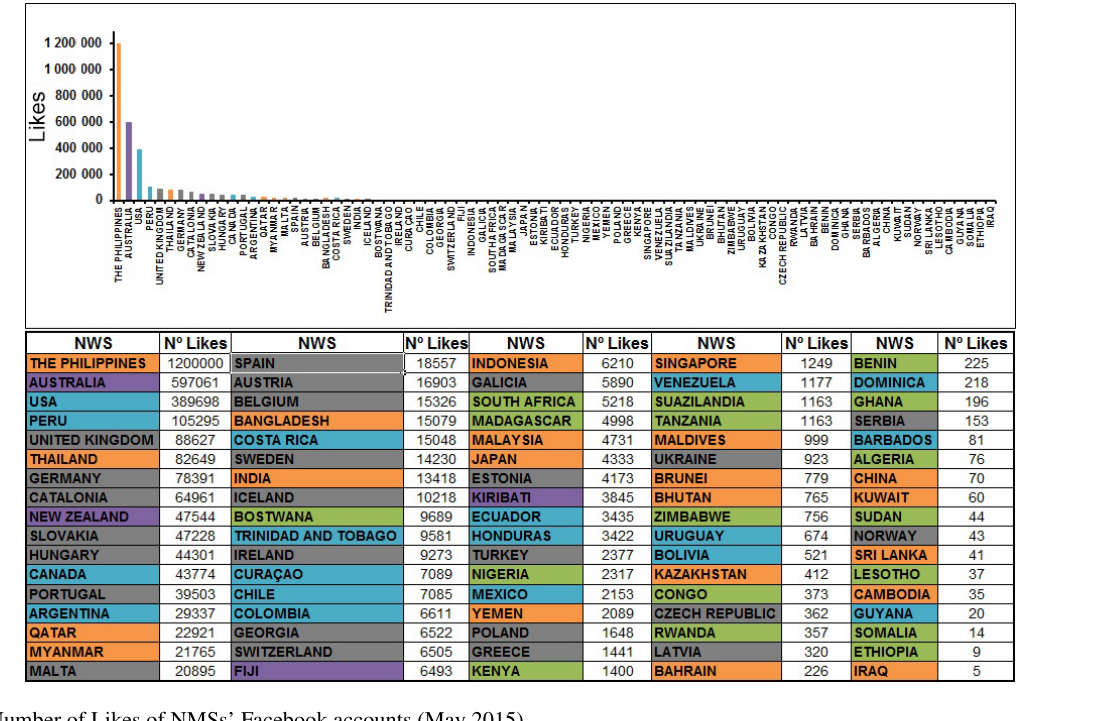
Figure 3. Number of Likes of NMSs’ Facebook accounts (May 2015).